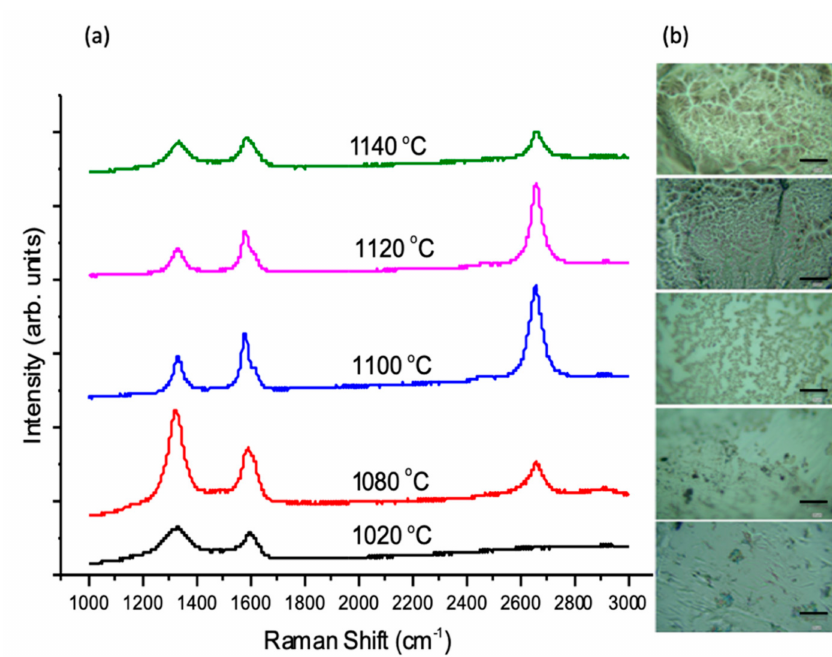
Figure 5. ( a ) Raman spectra of graphene grown on liquid Sn at di ff erent growth temperatures on liquid Sn using the optimised growth conditions on Sn (APCVD, 25 H 2 / 250 Ar / 5CH 4 sccm, t = 5 min.). ( b ) Optical images of the deposited graphene film (scale bar 20 µ m); some blurriness is due to the surface curvature of the solidified Sn after